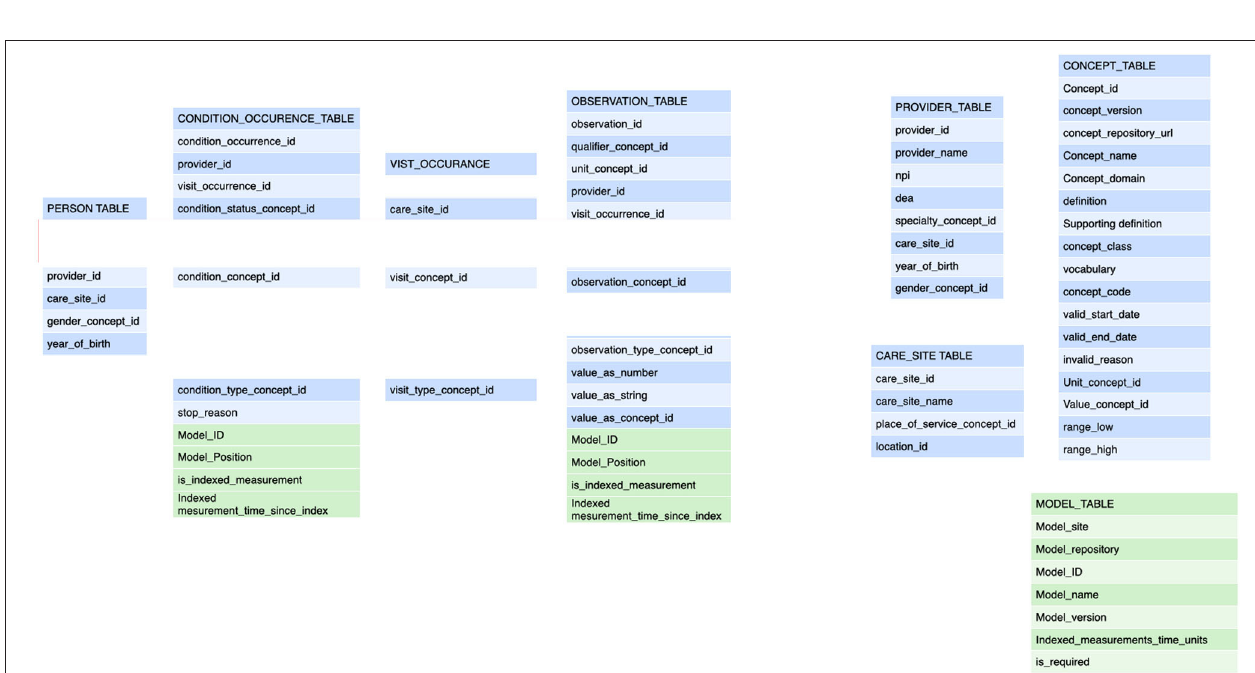
FIGURE 4 | The general map of how the FHIR Careplan was constructed. Thus, FHIR observations generated on the basis of the individual care plan have information on vocabulary and its related value concepts as well as plan origin and placement in the plan. From this, all semantic information can be reconstructed for analytical